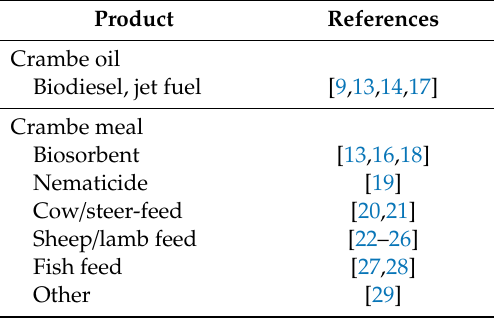
Table 1. Crambe oil and meal uses and research reported between 2010 and 2018.